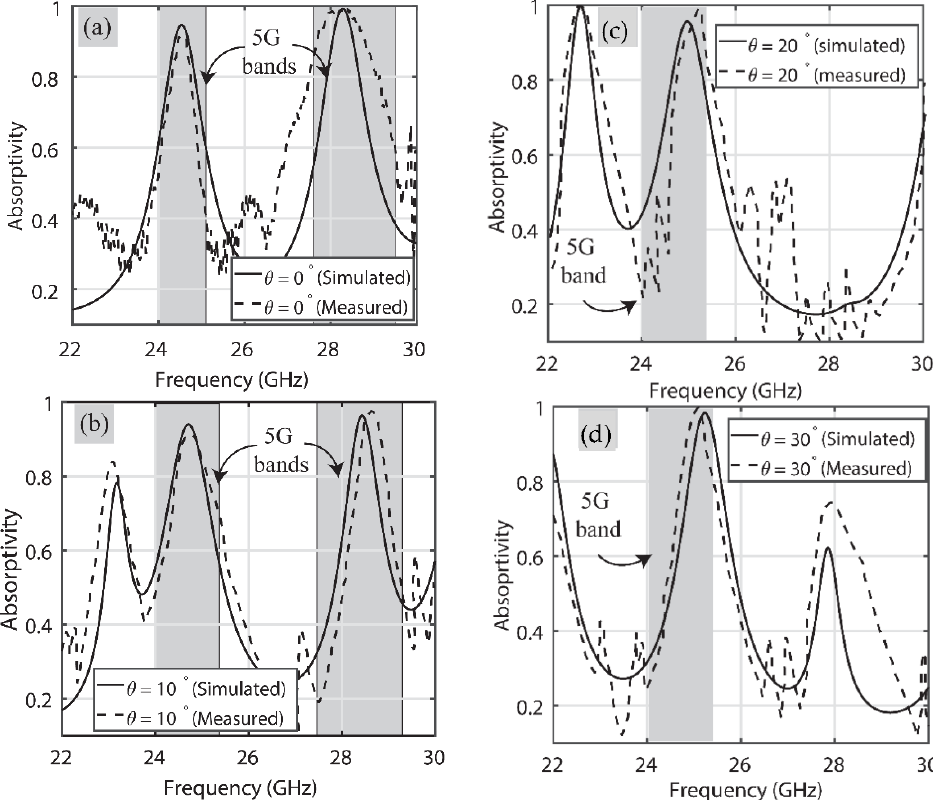
Figure 10. Performance comparison of the proposed MA for TE polarization at ( a ) 0°, ( b ) 10°, ( c ) 20° and ( d ) 30°.